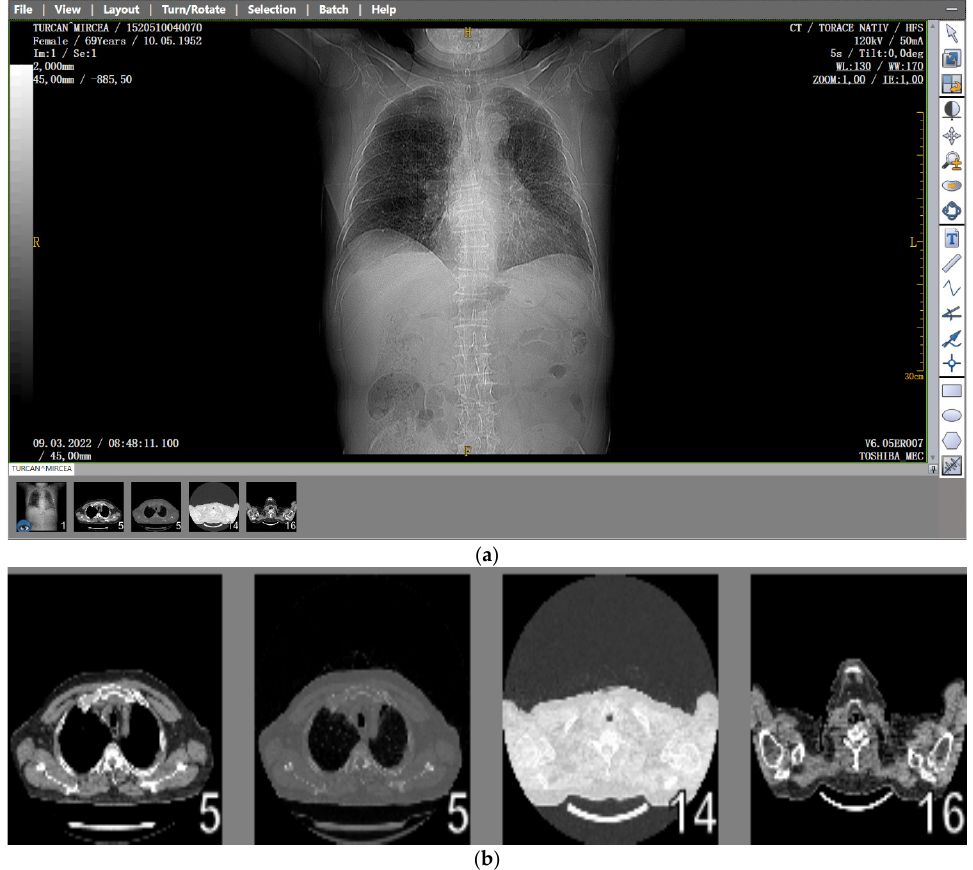
Figure 1. ( a ) The CT scan image of a 69-year-old patient who underwent a chest CT examination due to suspicion of COVID-19 in the lungs. ( b ) A schematic representation of the pre-processing phases of the patient’s CT image (2D), which was resampled to an isomorphic resolution. The indices 5, 14, and 16 represent the numbers of the slices in order. 3.1. Patient Code: MT Date of performing the pulmonary investigation: 9 March 2022.